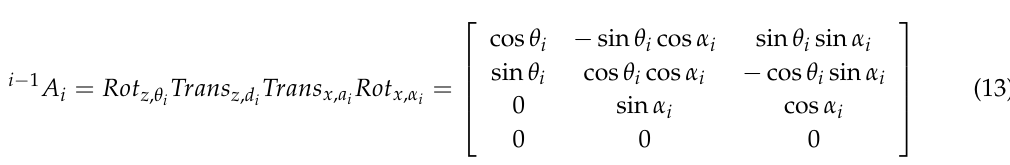
Table 1. D-H parameters for UR10 robot.